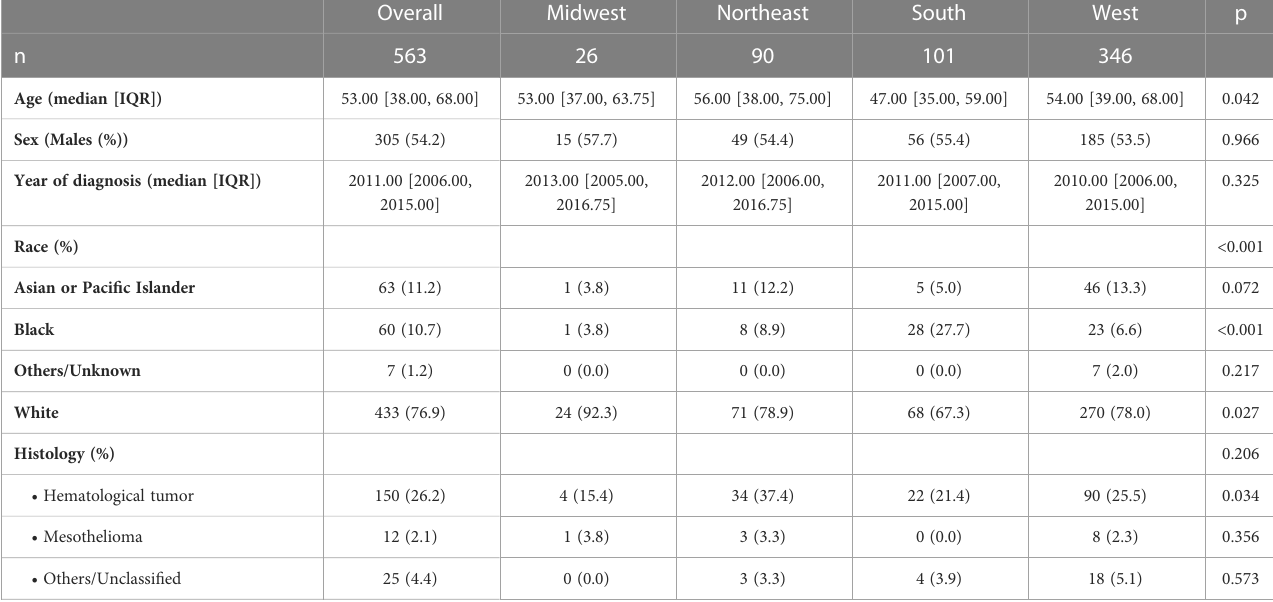
TABLE 1 Criteria of included